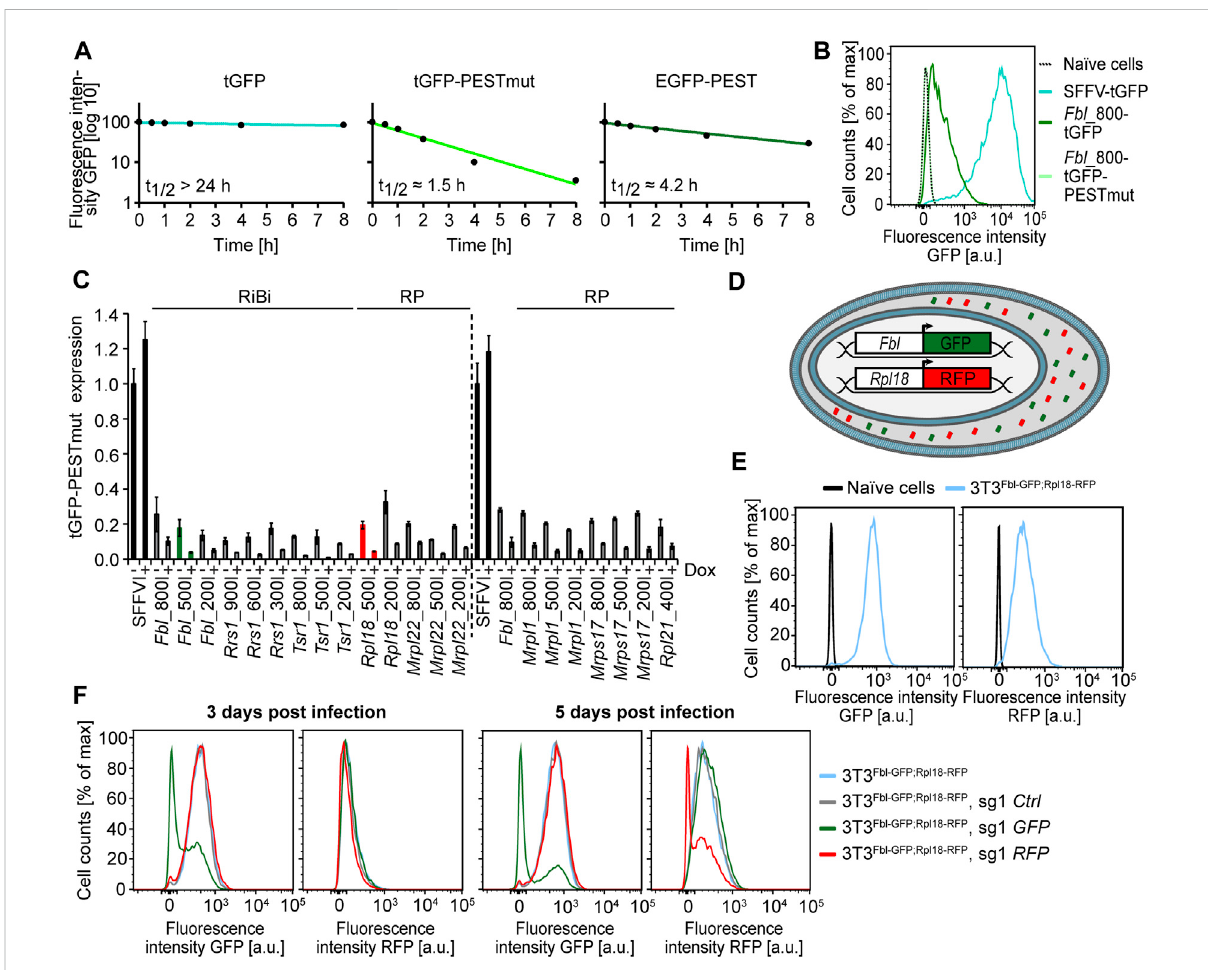
FIGURE 1 Reporter and promoter choice, generation of the screening cell line and testing of positive control sgRNAs. (A) Protein stability assay on different green fl uorescent protein reporters. Median green fl uorescence of TurboGFP (left panel), TurboGFP fused to a triple alanine mutated (E428A/E430A/E431A) PEST domain of the mouse ornithine decarboxylase (mODC) protein (middle panel), and enhanced GFP (eGFP) fused to the wild type mODC PEST domain (right panel), (Left panel) CHX (100 μ g/ml) assay on HEK cells expressing SFFV-driven TurboGFP (tGFP) Single experiment,(Middle panel) CHX (100 μ g/ml) assay onHEK cells expressingSFFV-driven tGFP-PESTmutSingle experiment,(Rightpanel) CHX(10 μ g/ ml) assay on U2OS cells expressing SFFV-driven EGFP-PEST. Single experiment. (B) Fluorescence intensity of GFP variants driven by different reporters. Murine embryonic fi broblast (MEF) cells were infected with the indicated reporter constructs and analyzed by FACS. Single experiment. Naïve cells = uninfected MEFs, SFFV = spleen focus forming virus promoter, Fbl_ 800 = Fibrillarin promoter fragment of approx. 800 bp. (C) Quantitative real-time PCR (qRT-PCR) of RiBi- and RP-promoter-driven tGFP-PESTmut reporter transcripts upon MYC depletion. T lymphoma MYC − Tet-Off cells were infected with the indicated reporter constructs, which are labelled to re fl ect the respective gene promoter and its length (in bp), and treated with Dox (1 μ g/ml) for 16 h – 24 h. Expression was analyzed normalized to ß-Actin . The dashed line separates two different runs. Representative experiment from a duplicate (for some promoters a triplicate) experiment. The green and red promoters were chosen for further usage in the screen. RiBi = Ribosome biogenesis gene promoter, RP = ribosomal protein gene promoter. Error bars represent standard deviation of technical triplicates. (D) Schematic representation of the cell line used for the genome-wide reporter screen. EGFP-PEST (GFP) expression is driven by the murine Fibrillarin ( Fbl ) promoter. tRFP-PEST (RFP) expression is driven by the murine Ribosomal protein L18 ( Rpl18 ) promoter. The EGFP-PEST and tRFP-PEST proteins are depicted in the cytoplasm as green and red barrels, respectively. (E) FACS analysis of the cell lineused forthegenome-widereporterscreen.3T3 Fbl − GFP; Rpl18 − RFP isamurine NIH/3T3cellline,that expressesEGFP-PEST(GFP)underthecontrol of theapprox.500 bp Fbl promoterfragmentandtRFP-PEST(RFP)underthecontroloftheapprox.500 bp Rpl18 promoterfragment. NaïveNIH/3T3= uninfected NIH/3T3 cells. (F) FACS analysis of the time-dependent effects of sgRNAs targeting EGFP-PEST (GFP) or tRFP-PEST (RFP) on reporter expression. Three days (left panel) or fi ve days (right panel) after infection of the screening cell line 3T3 Fbl − GFP; Rpl18 − RFP Single